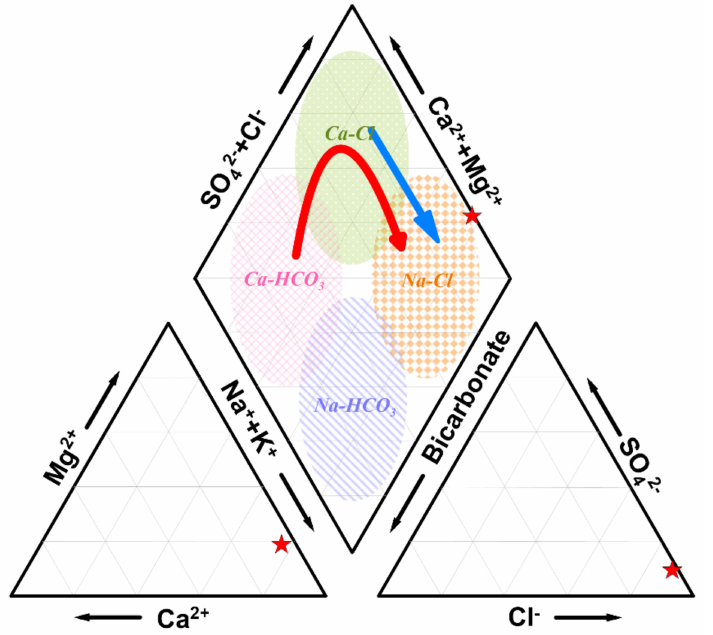
Figure 2. Piper diagram representing the mixing of groundwater and seawater. A red star represents the chemical composition of seawater. The mixing between seawater and Ca-HCO 3 is indicated by the red arrow and the mixing between seawater and Ca–Cl-type water is indicated by the blue